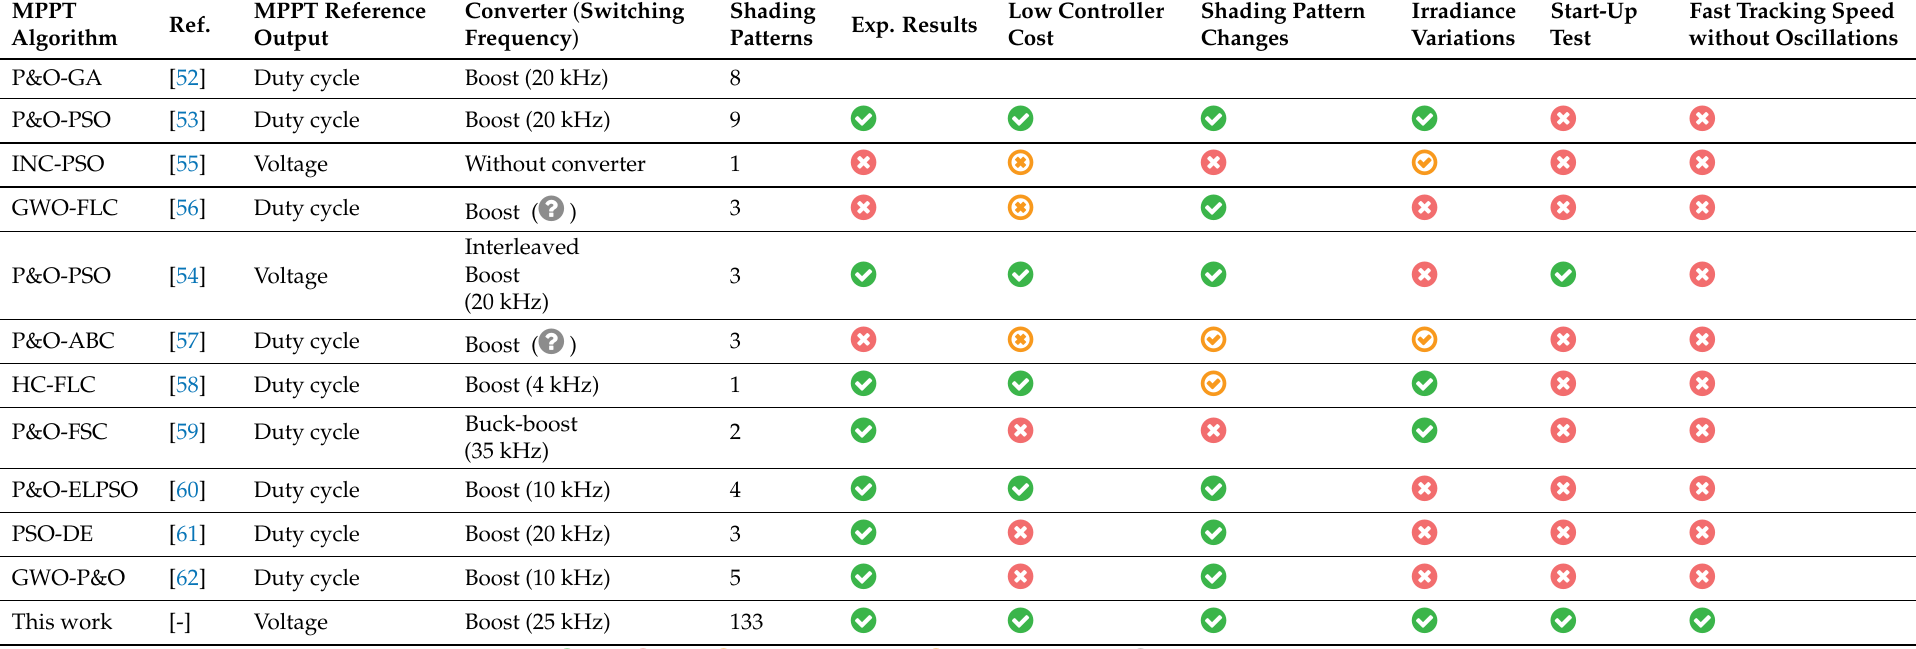
Table 1. A comparison of hybrid MPPT